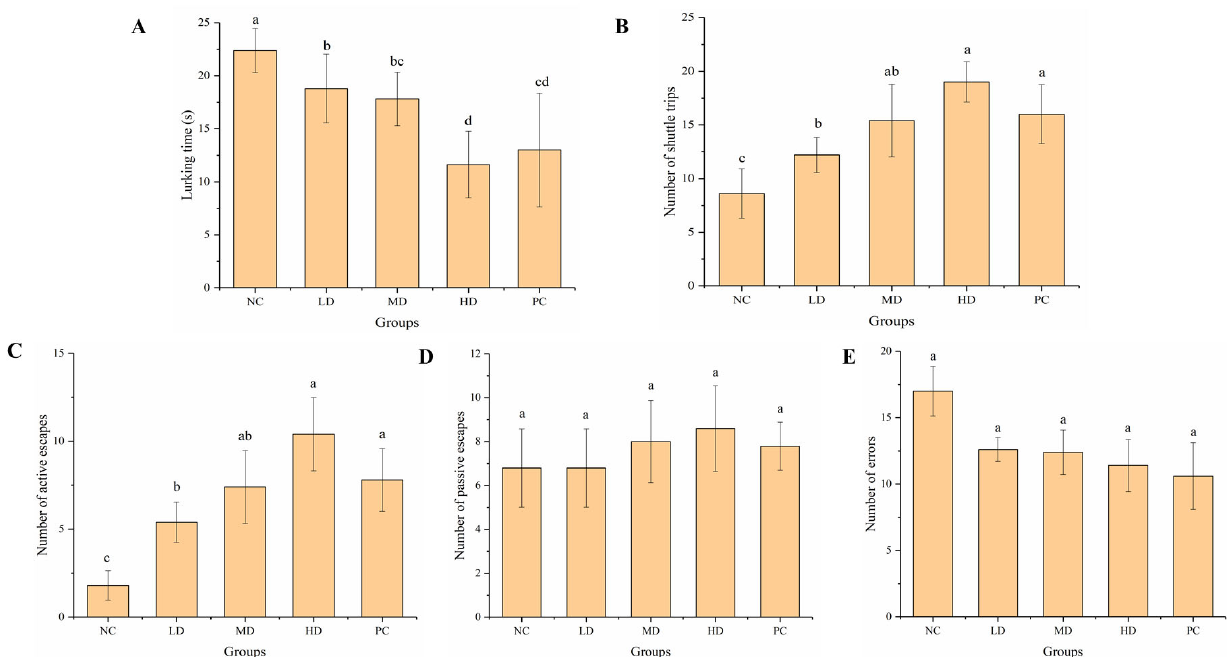
Figure 3. Results of passive avoidance test. ( A ) Lurking time in mice from different groups. ( B ) Number of shuttle trips in mice from different groups. ( C ) Number of active escapes in mice from different groups. ( D ) Number of passive escapes in mice from different groups. ( E ) Number of errors in mice from different groups. Different lowercase letters represent significant differences between groups ( p < 0.05). NC: normal control, LD: low dose, MD: middle dose, HD: high dose, PC: positive control.